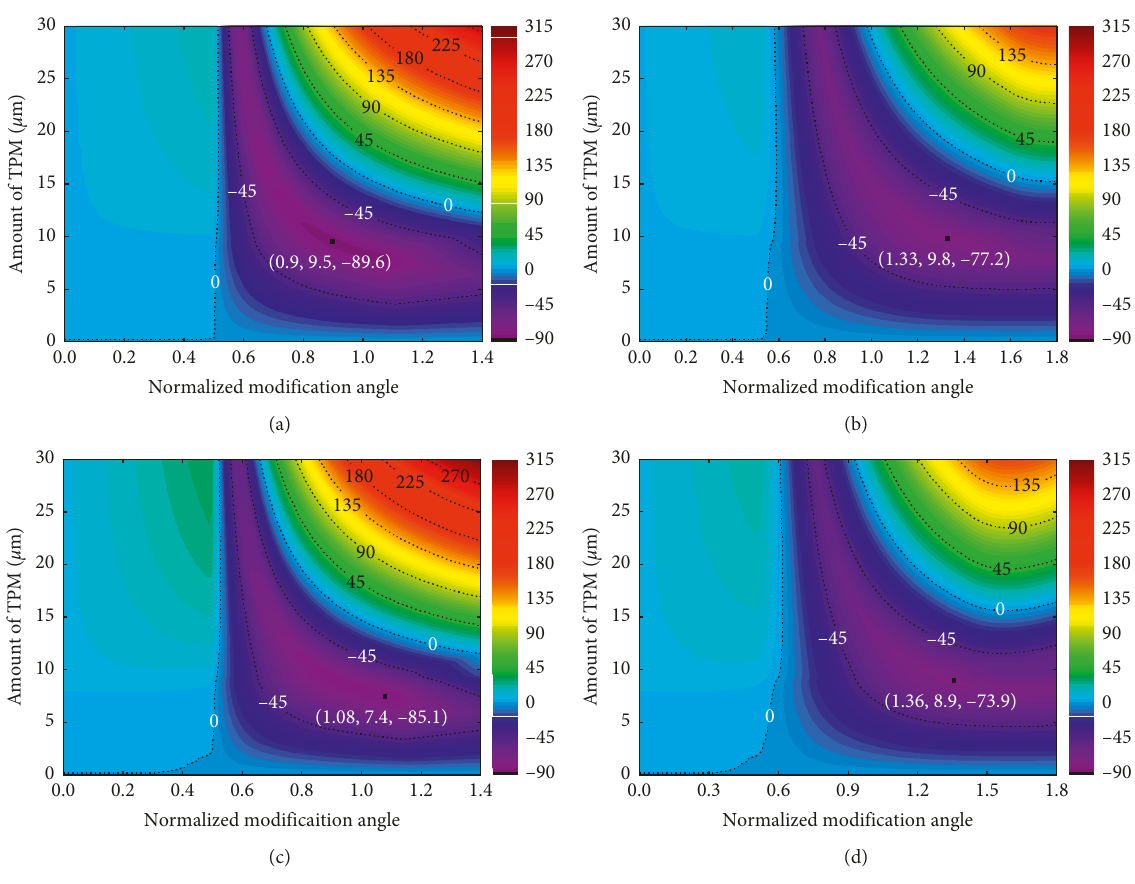
Figure 16: Relative peak-peak value of the LSTE (unit:%): (a) external meshes with linear modification, (b) external meshes with parabolic modification, (c) internal meshes with linear modification, and (d) internal meshes with parabolic